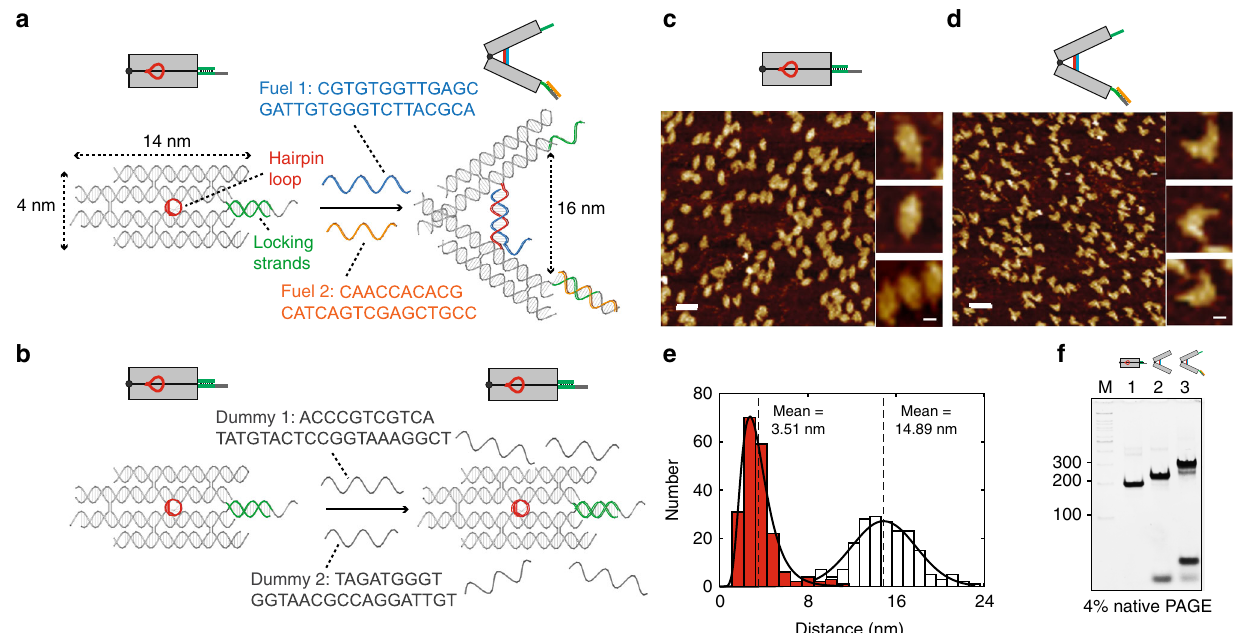
Fig. 1 Design of DNA tweezers and characterization of closed and open tweezers. a Design and dimensions of a closed tweezer with locking strands (green) and an open tweezer with addition of fuel strand 1 (FUEL 1, blue) and fuel strand 2 (FUEL 2, orange). b Control tweezers with dummy fuel strands 1 and 2 (gray). c Zoom-out and zoom-in AFM images of closed tweezers with locking strands. d Zoom-out and zoom-in AFM images of open tweezers after addition of both fuel strands. Scale bars are 50 nm for zoom-out images and 10 nm for zoom-in images. e Histograms for the distance between the ends of the tweezer arms based on AFM imaging (red and white histograms are separate samples of closed and open tweezers, respectively). f Native PAGE gel characterization of tweezer opening: lane M, double-stranded DNA ladder as a standard marker (distance along the gel marked in units of base pairs); lane 1, closed tweezer with locking strands; lane 2, open tweezer with addition of FUEL 1; lane 3, open tweezer with both FUEL 1 and FUEL 2